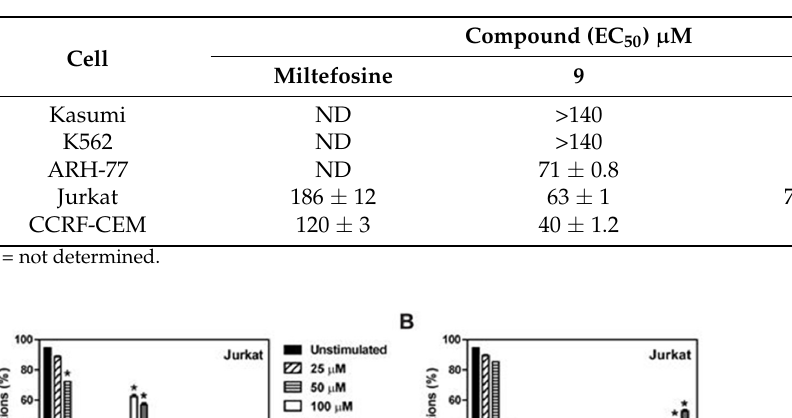
Table 1. Effects of the alkyltriazole compounds 9 and 21 on different myeloblastic and lymphoblastic leukemia cell lines.